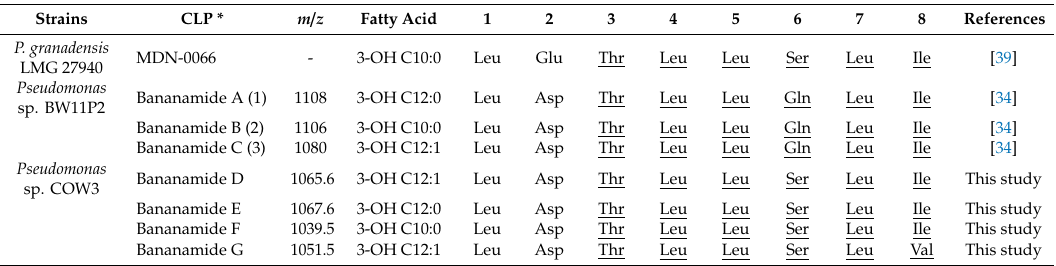
Figure 3. Chemical structure of bananamide D, E, F and G, with m / z values and corresponding CLP sequences showing amino acids involved in cyclization. Hydrophobic amino acids are indicated in green, hydrophilic amino acids in pink. Table 2. Amino acid sequences of bananamide D-G CLPs and related bananamides. The fatty acid is a 3-hydroxy fatty acid with either 10 or 12 carbons and either 0 or 1 unsaturation (double bond). Amino acids forming the macrocycle are underlined.